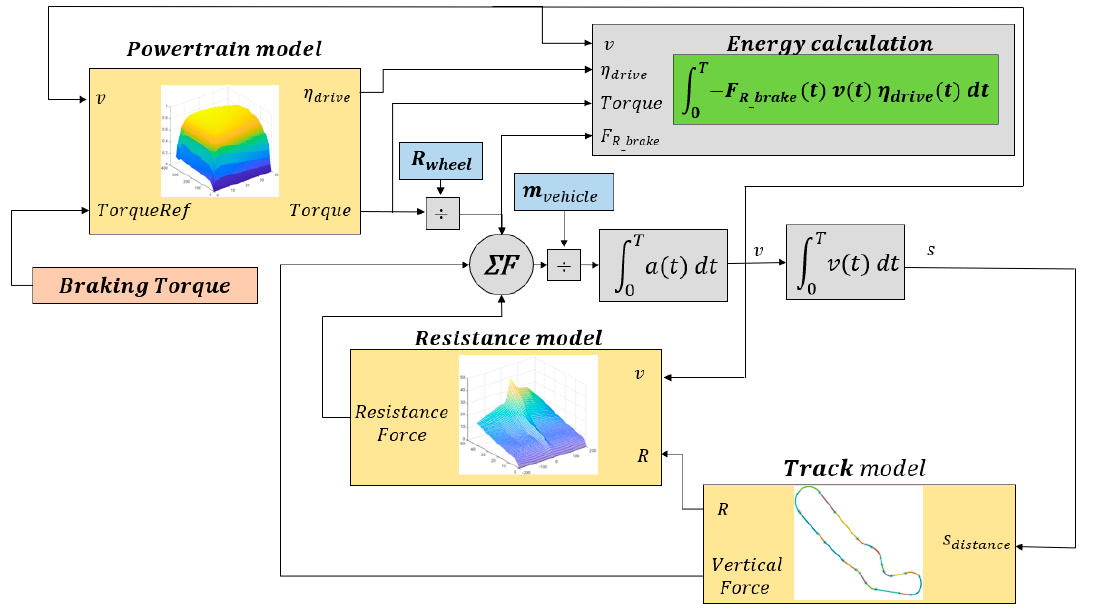
Figure 3. Schematic of optimization framework for regenerative braking.